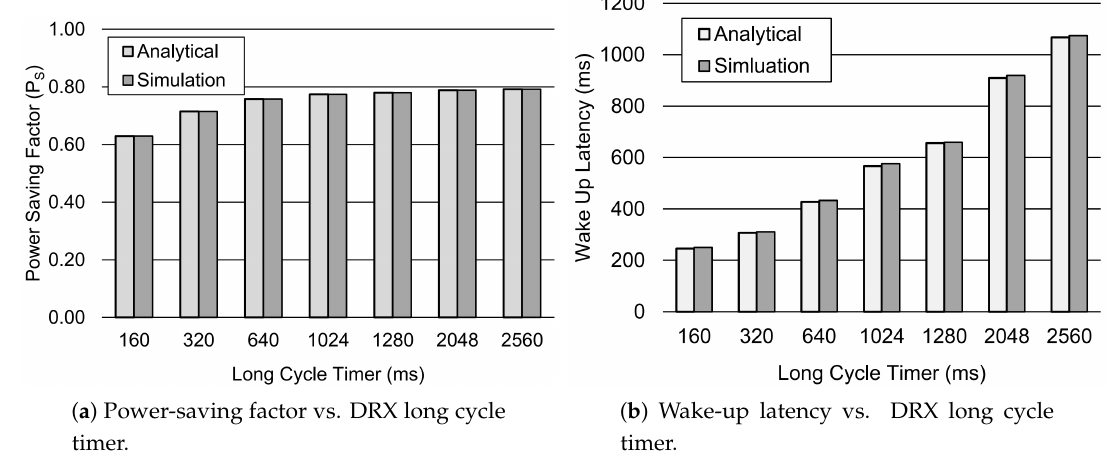
Figure 7. Performance analysis of the DRX mechanism for different values of T LC . Other parameter settings include 1